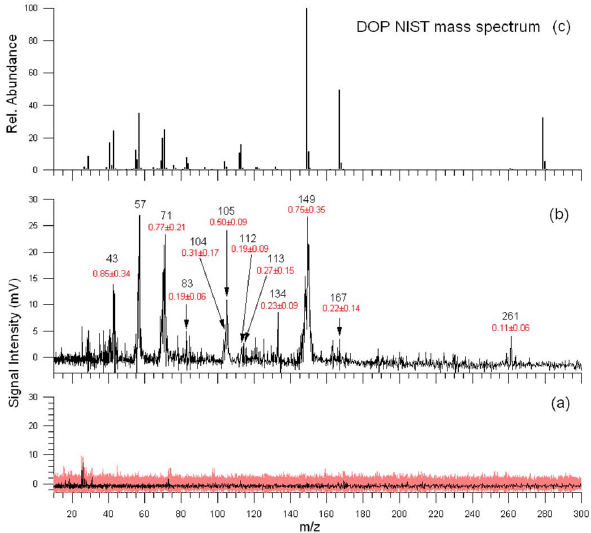
Fig. 7. (a) Typical noise level on the mass spectra obtained for a single laser pulse when aerodynamic lens system has sampled a filtered N 2 flux. The red shaded area, calculated as three times the standard deviation obtained at each mass, corresponds to the maximum and minimum thresholds of an ion signal to be considered as significant, (b) typical mass spectrum of an individual DOP particle (170 <d aev < 900nm). The mean intensity ratios of each detected mass peak normalized to m/z 57 and their associated standard deviation (calculated from 50 single particle DOP mass spectra) are indicated in red below the mass peak identifications, (c) DOP NIST mass spectrum (electron ionization) (NIST, 2010).